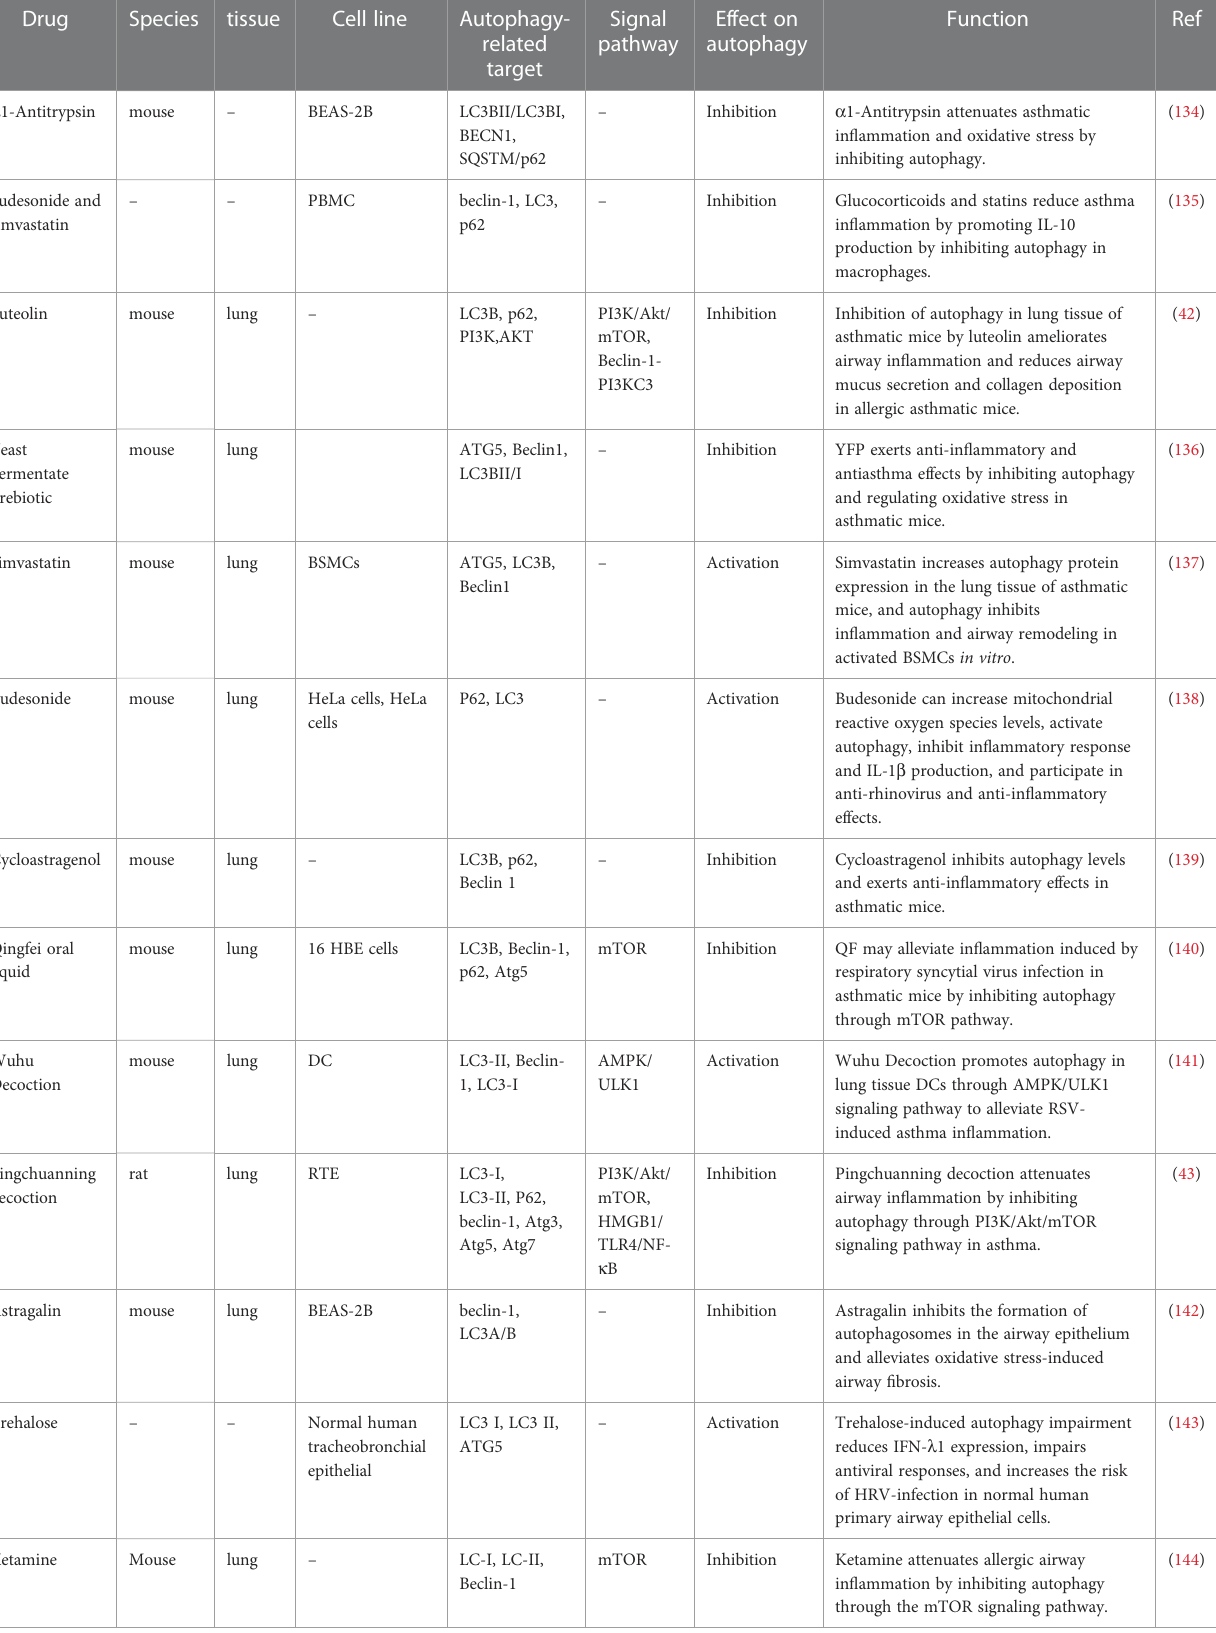
TABLE 1 Mechanisms of action of drug-mediated autophagy on allergic airway in fl ammation in vivo and in vitro